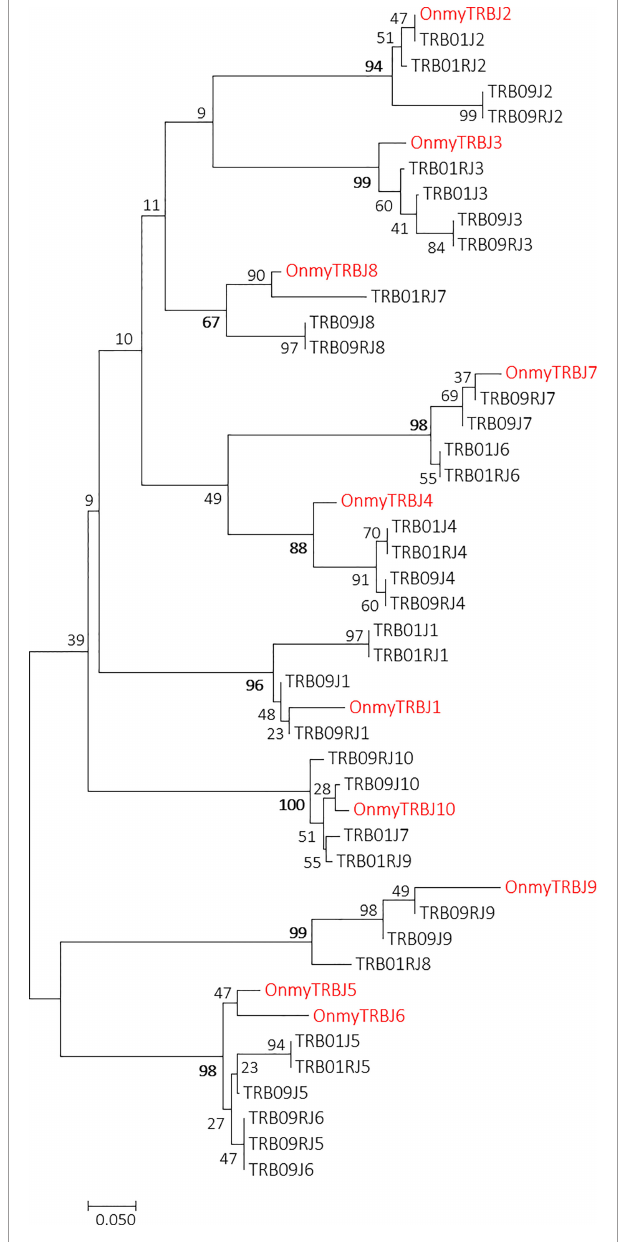
FIGURE 4 | Phylogeny of rainbow trout and Atlantic salmon TRBJ nucleotide sequences. GenBank accession number for the rainbow trout sequences is U97590 (14). The optimal tree with the sum of branch length = 3.25637896 is shown. The evolutionary distances were computed using the Maximum Composite Likelihood method (51) and are in the units of the number of base substitutions per site. The analysis involved 46 nucleotide sequences. Codon positions included were 1st+2nd+3rd+Noncoding. There were a total of 55 positions in the fi nal dataset. Rainbow trout sequences are shown using red